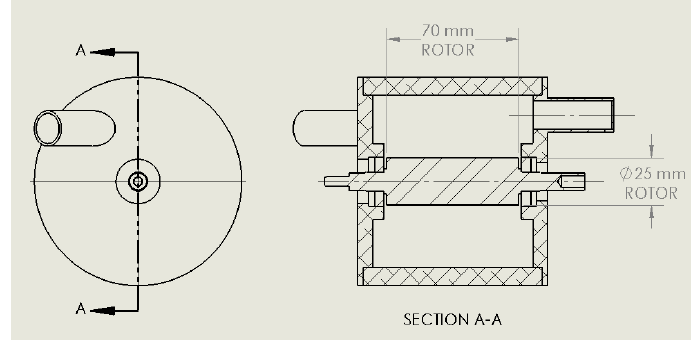
Figure 6. Experimental apparatus bearing loss calibration fixture.